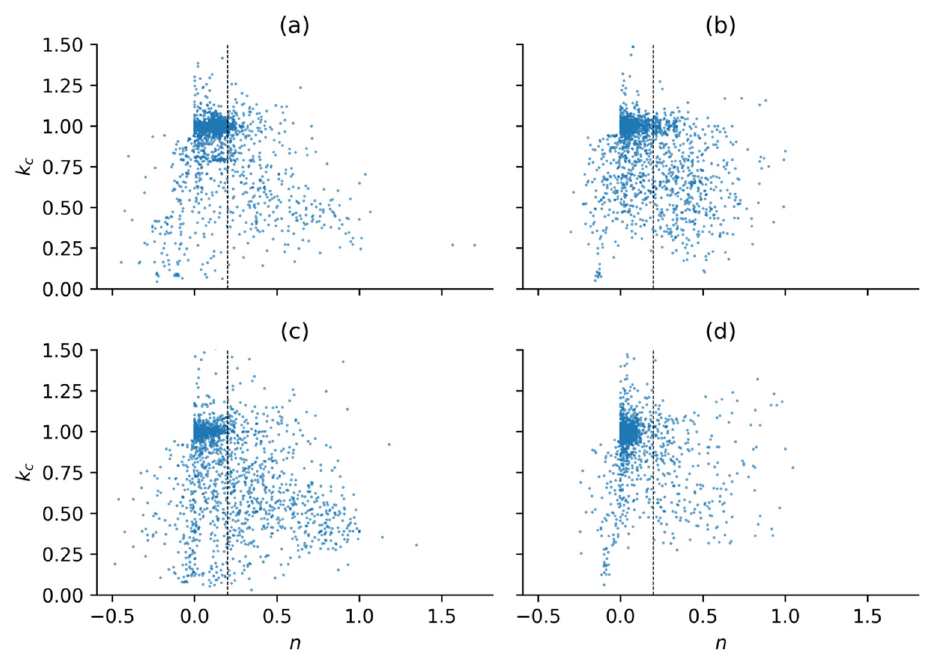
Figure 3. The relationship between the clear sky index ( k c ) and cloud index ( n ) in the benchmarking period for: ( a ) QLD-A; ( b ) QLD-B; ( c ) VIC-A; ( d ) QLD-C. A vertical black dashed line at n = 0.2 separates the relationship between k c and n .